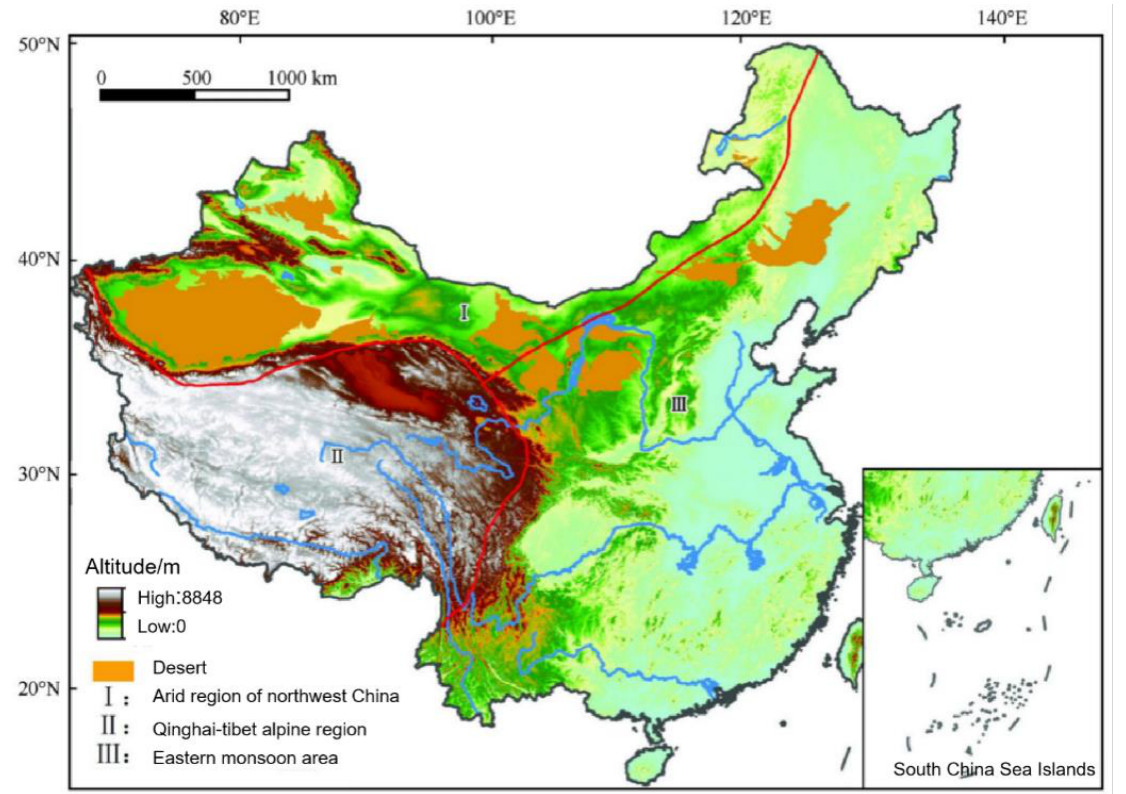
Figure 1. Schematic of the desert and sandy land areas in China.